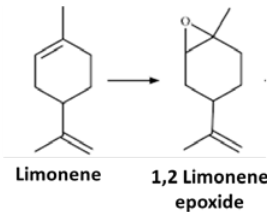
Figure 6. Limonene epoxidation.